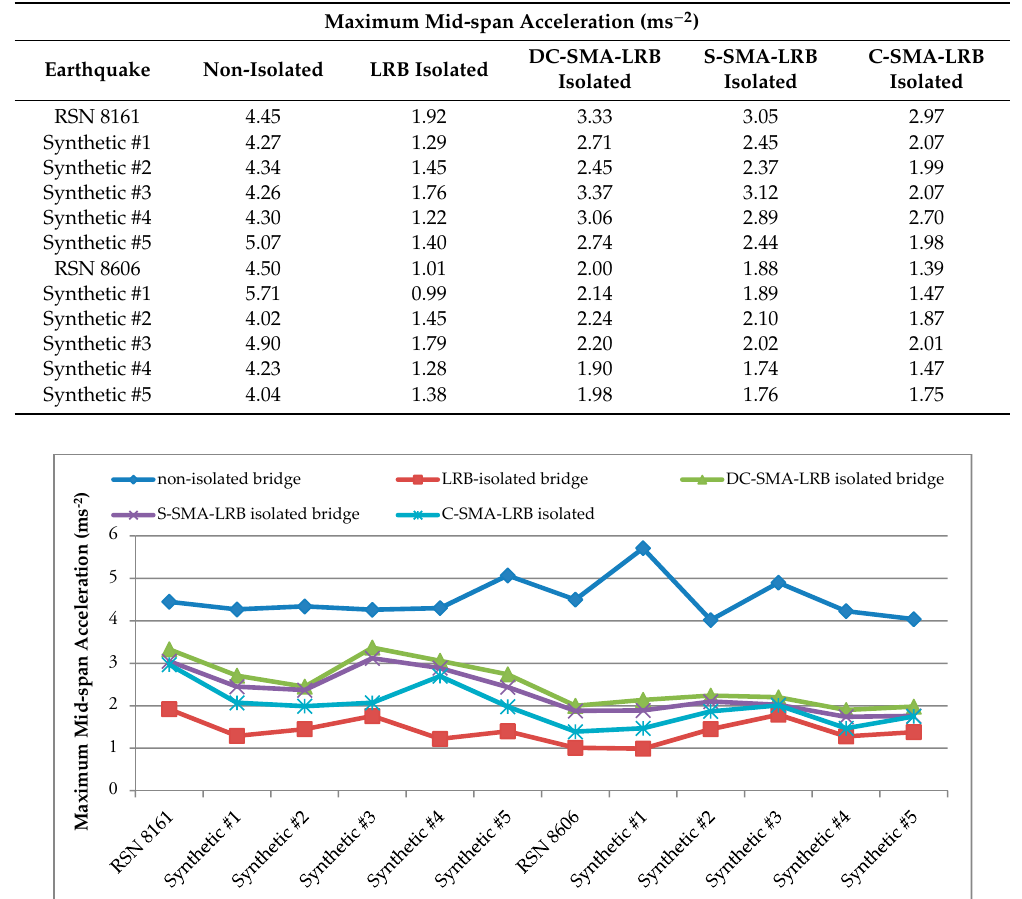
Table 5. Maximum mid-span acceleration for the non-isolated, LRB-isolated and three SMA-LRB isolated bridges.